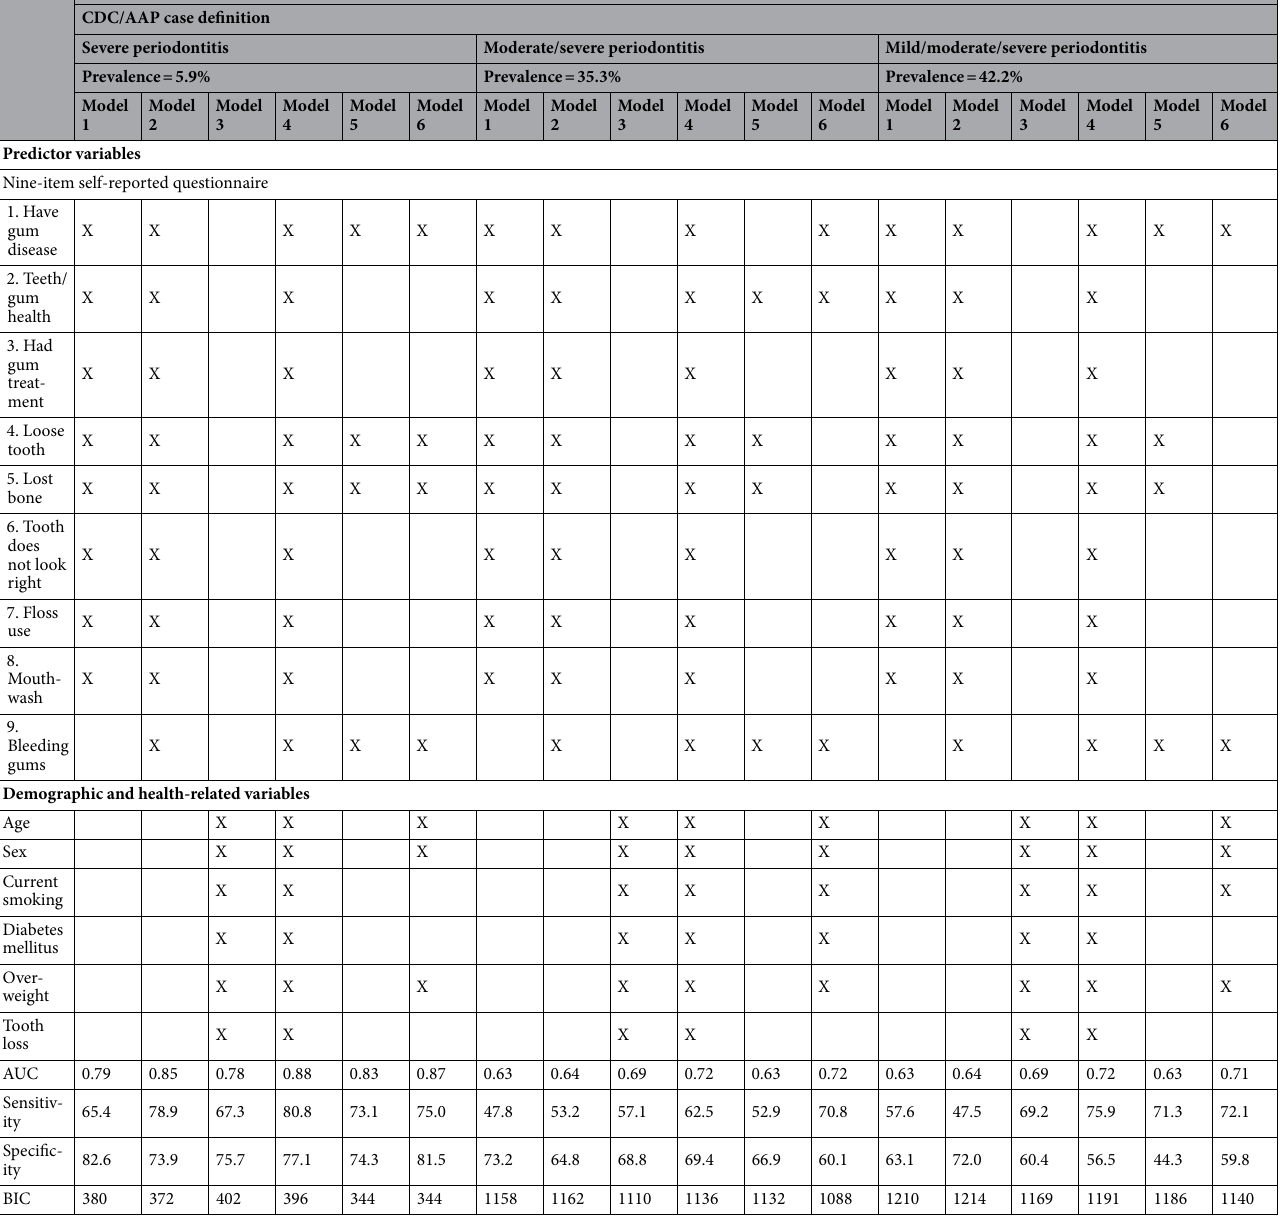
Table 4. Logistic regression models for periodontitis among Japanese adults (N = 883). Model 1 includes the 8-item self-reported questionnaire for oral health. Model 2 added the question on bleeding gums to Model 1. Model 3 includes demographic and health-related variables. Model 4 includes a combination of self-reported oral health questions and demographic and health-related variables (full model). Model 5 includes the